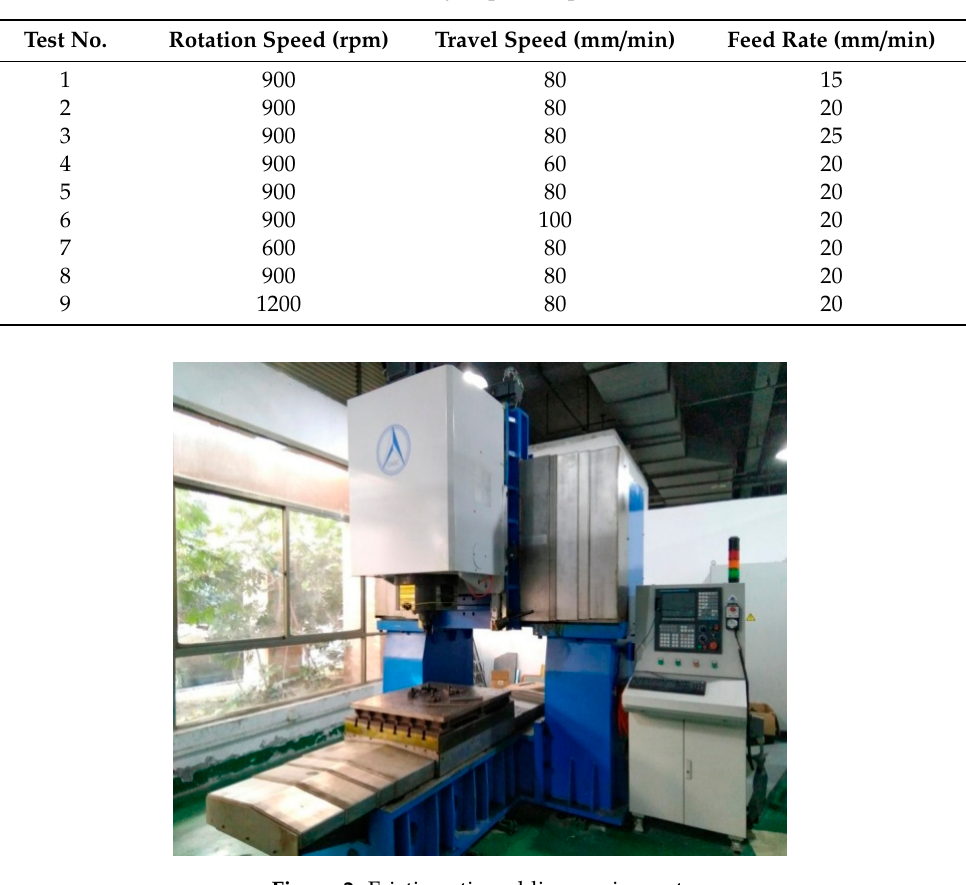
Table 2. Chemical composition (in wt %) of the DH36 steel.